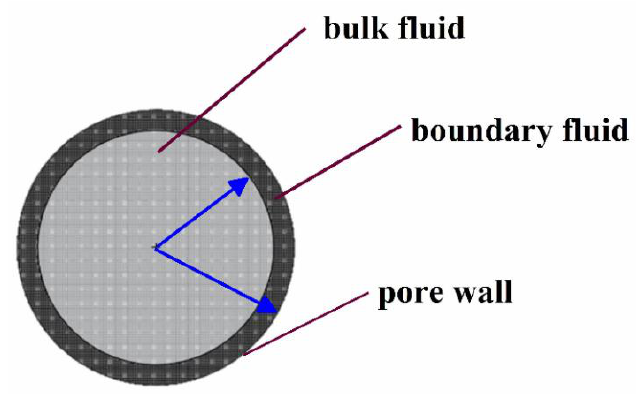
Figure 1. The distribution of seepage fluid in pores.